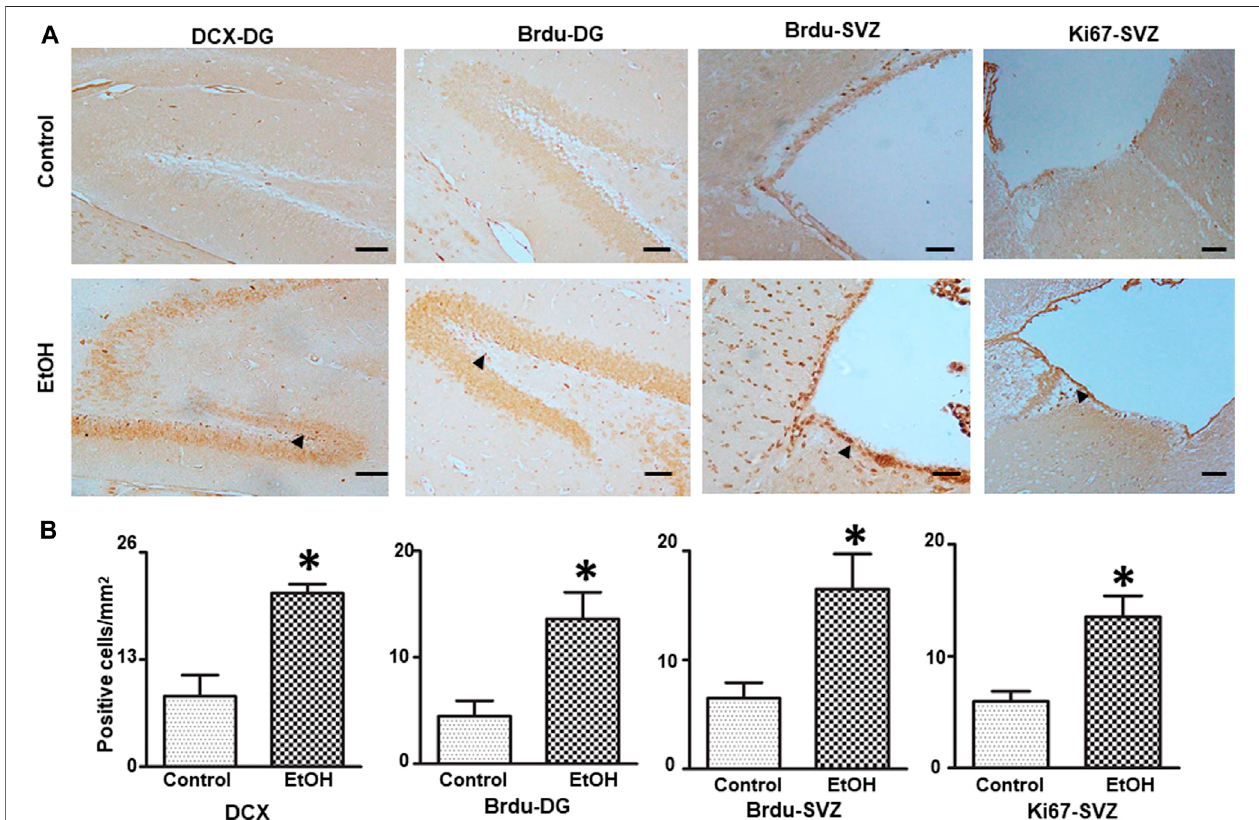
FIGURE 9 | Effects of chronic alcohol exposure on neurogenesis in the subventricular zone (SVZ) and dentate gyrus (DG) of the hippocampus. Both control and alcohol-exposedmicereceivedBrdUinjection. (A) BrdU-positivecellsintheDGandSVZweredeterminedbyIHC.ArrowsindicateBrdU-positivecells;bar (cid:2) 50 μ m.The expression of doublecortin (DCX) inthe DG of thehippocampus and Ki67 in the SVZ were examined by IHC. Arrowsindicate DCX- and Ki67-positive cells; bar (cid:2) 20 μ m. (B) The number of DCX-, BrdU-, and Ki67-positive cells in the DG and SVZ was quanti fi ed as described in the “ Materials and Methods ” section. The results were expressed as mean ± SEM, n (cid:2) 3 or 4 for each group. * p < 0.05 denotes a statistically signi fi cant difference from the control